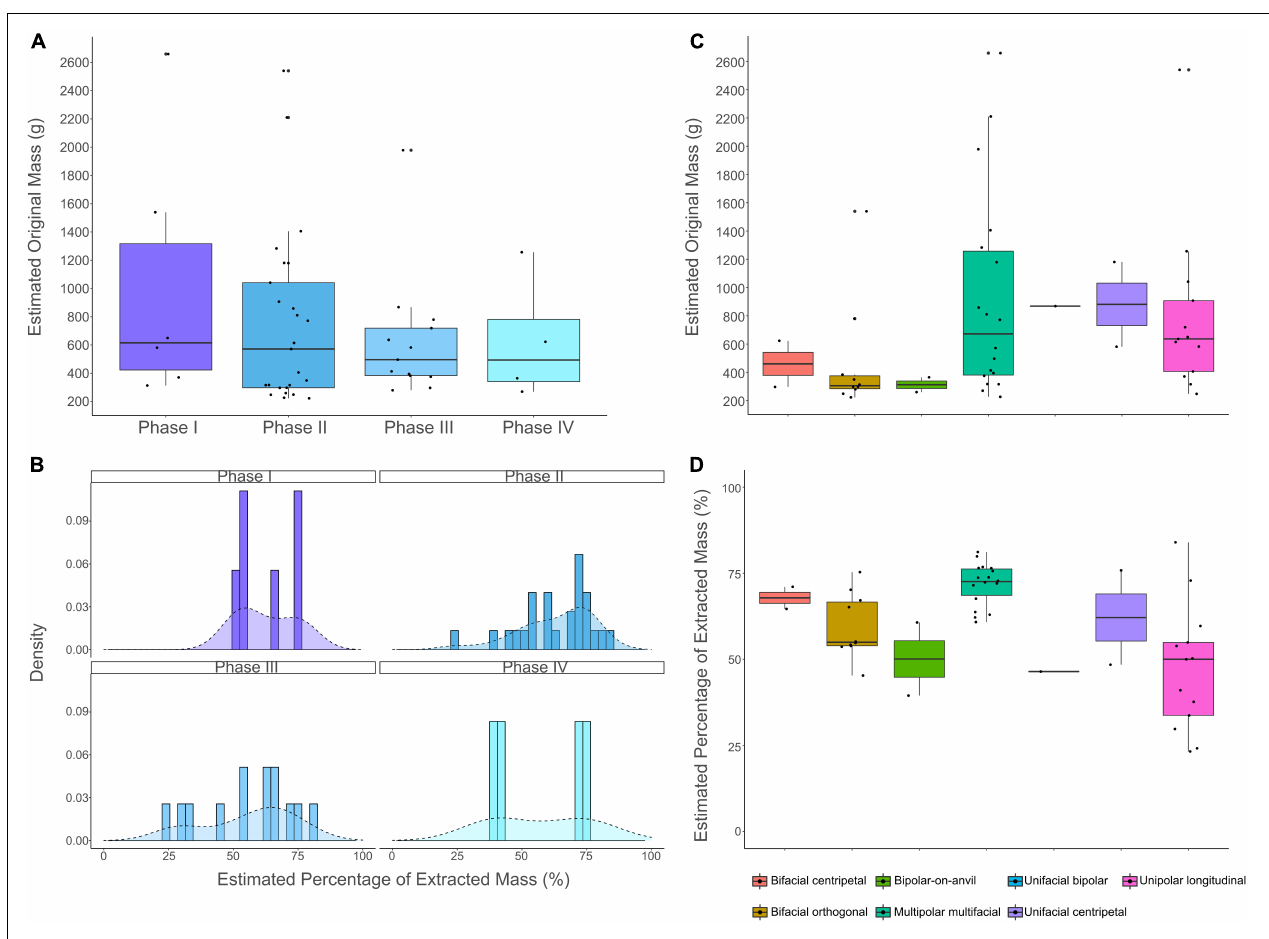
FIGURE 6 | Quantitative results obtained through the Volumetric Reconstruction Method (VRM). (A) Boxplot and jitter plot of Estimated Original Mass (in grams) of cores according to Phase. (B) Histogram of estimated percentage of extracted mass (%) of cores according to occupation Phases. (C) Boxplot and jitter plot of estimated original mass (in grams) of cores according to knapping method. (D) Boxplot jitter plot of estimated percentage of extracted mass (%) of cores according to knapping method. In (A,C,D) , the horizontal bars in the box represent the median. The box covers 50% of the central values, from the 1st (lower edge of the box) to the 3rd quartile (upper edge of the box). Upper whisker length represents data that are not 1.5 times greater than the third quartile. Lower whisker length represents data that are not less than 1.5 times the first quartile. Points represent values 1.5 greater or less than the 75th or 25th,